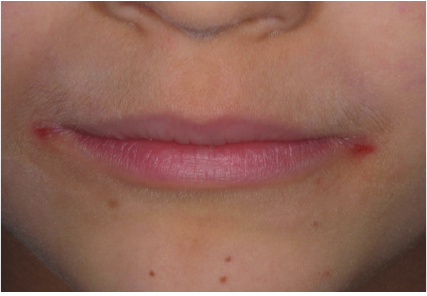
Figure 4: Angular cheilitis of minor size in a potential coeliac patient (B